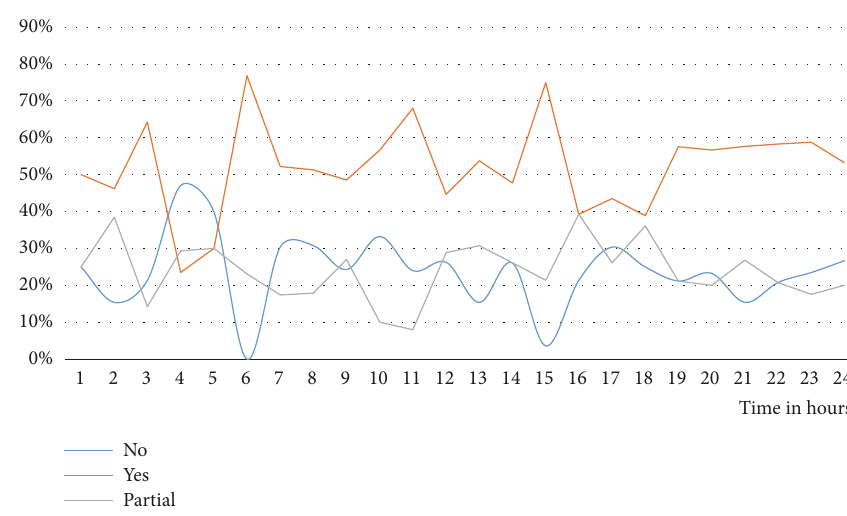
Figure 2: Fluctuations of the DM over 24 hours in